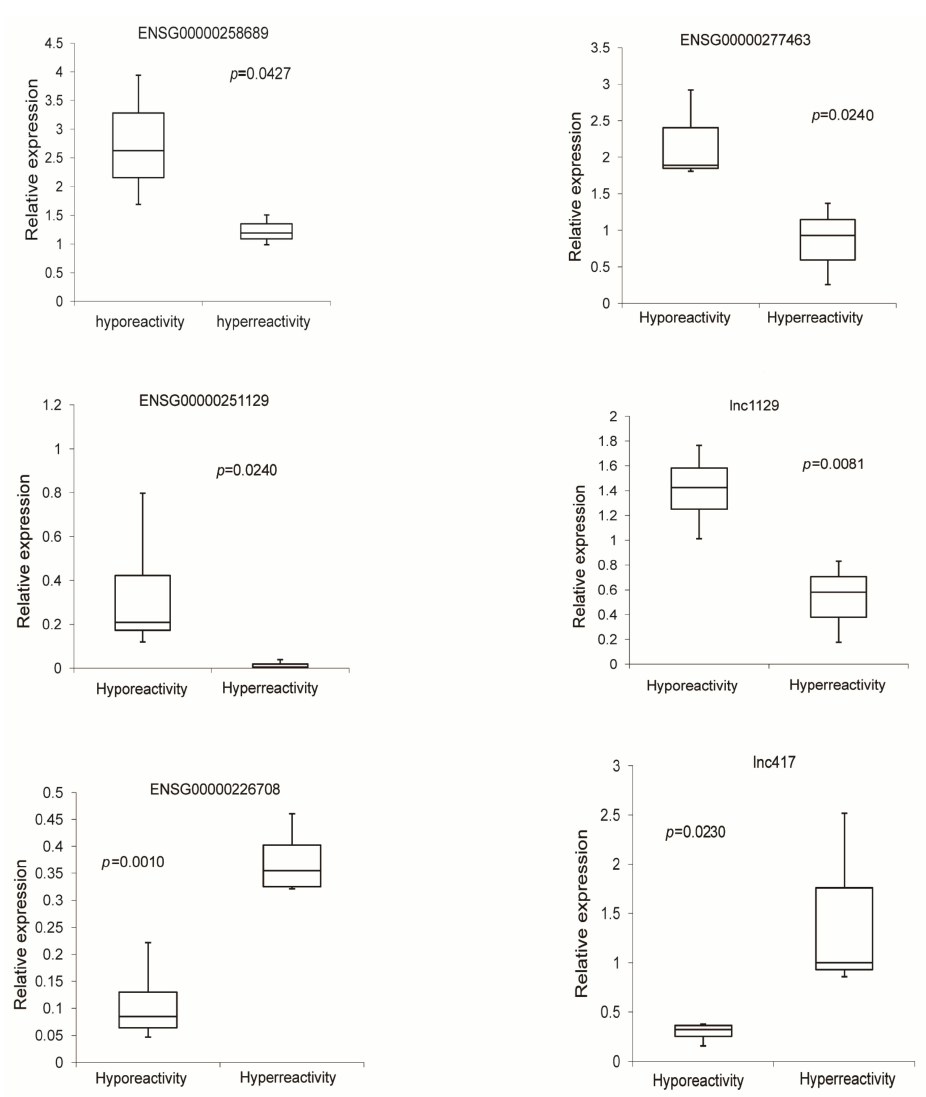
Figure 4. Quantitative real-time PCR validation of differentially expressed 6